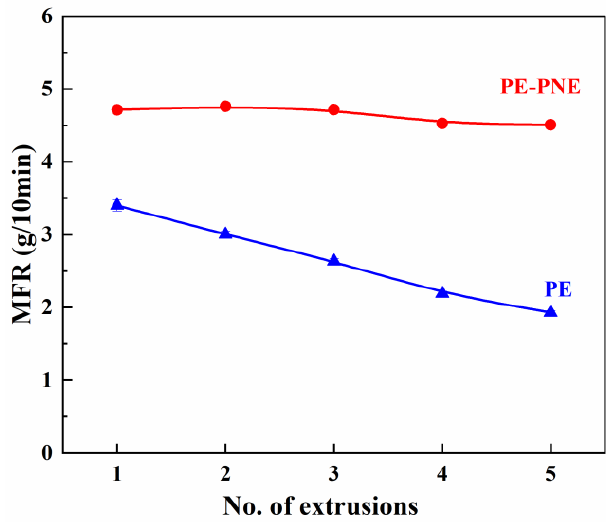
Figure 4. MFR values of PE and PE-PNE samples vs. the number of extrusions.